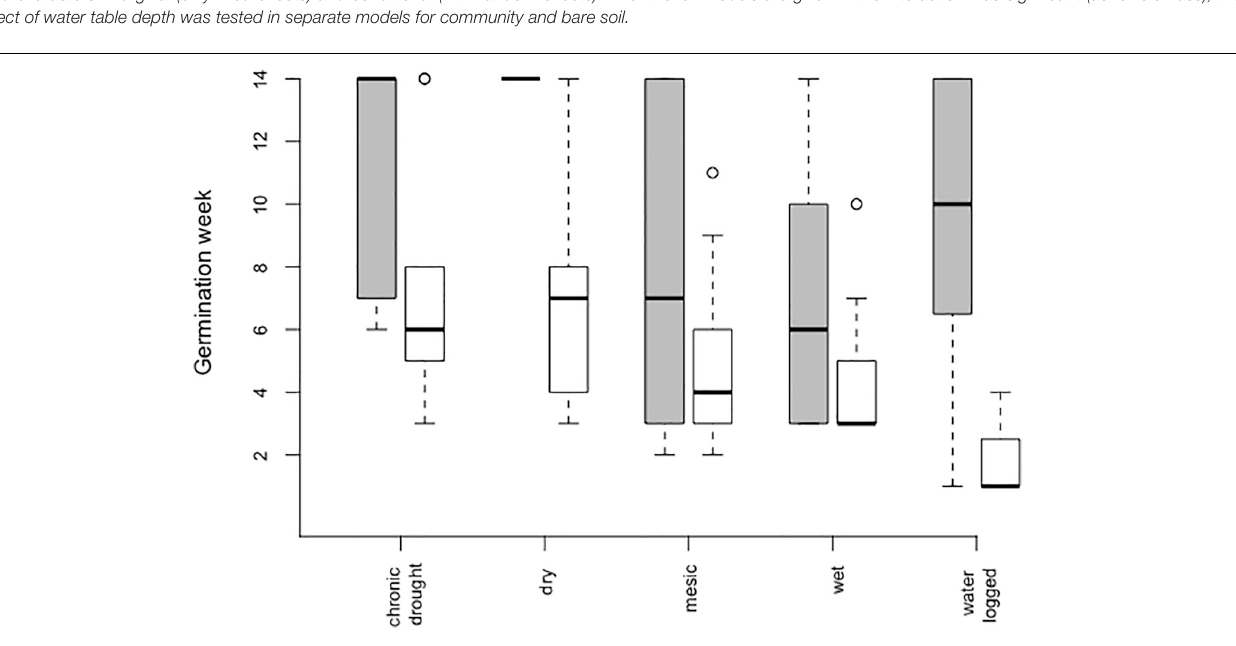
FIGURE 1 | Germination time in weeks after sowing of Bunias orientalis during the first season (2016) depending on water table depth treatment in the community (gray bars, n = 5, 3, 45, 34, and 7 individuals) and empty pots (white bars, n = 9, 14, 23, 22, and 3 individuals). Boxplots show the median per group (solid line), boxes represent the 25th and 75th quantile, whiskers the normal data range and circles the